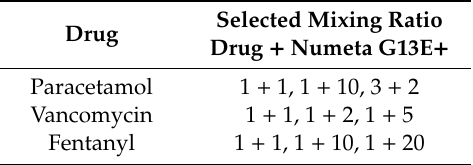
Table 3. Overview of selected mixing ratios of drug and Numeta G13E + for Y-site simulation.